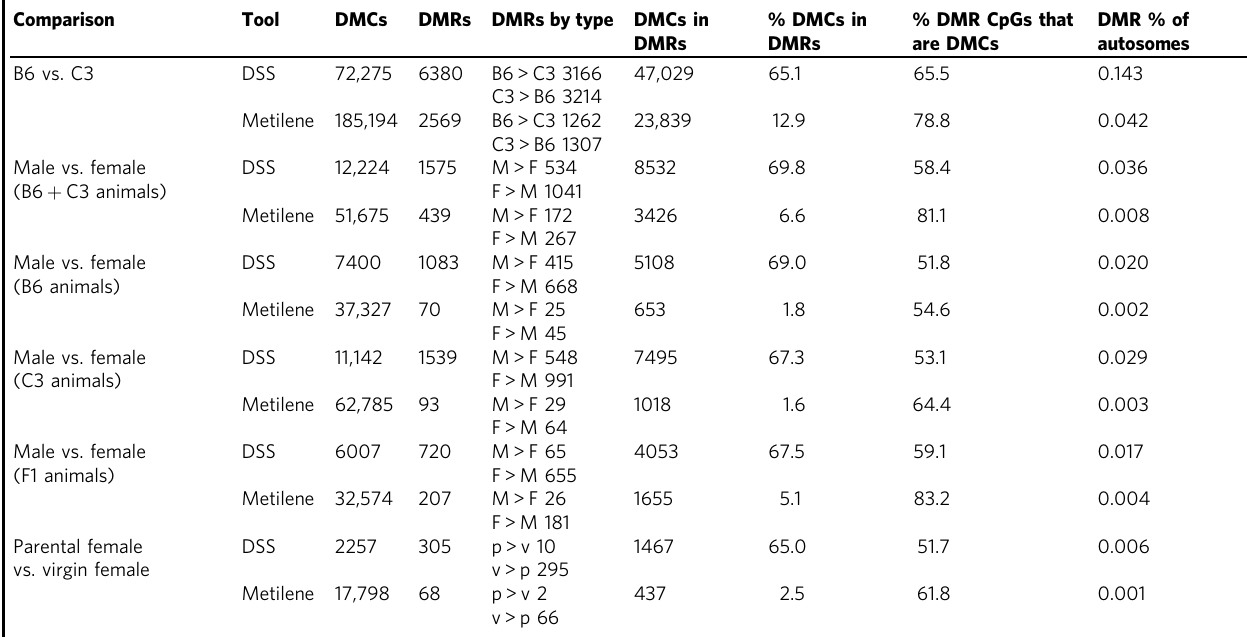
Table 1 Characteristics of differential methylation